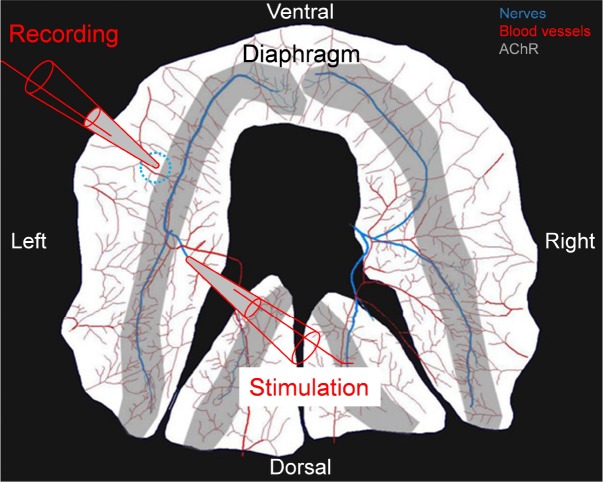
Drawing of experimental protocol to stimulate the phrenic nerve and record CMAPs in the diaphragm muscle.The phrenic nerve was placed in a bipolar suction electrode for stimulation. CMAPs were recorded from a suction recording electrode placed in the same place (dotted circle) across the different animals used in this study. The phrenic nerve is shown in blue, the blood vessels in red and the area with acetylcholine receptors in grey.